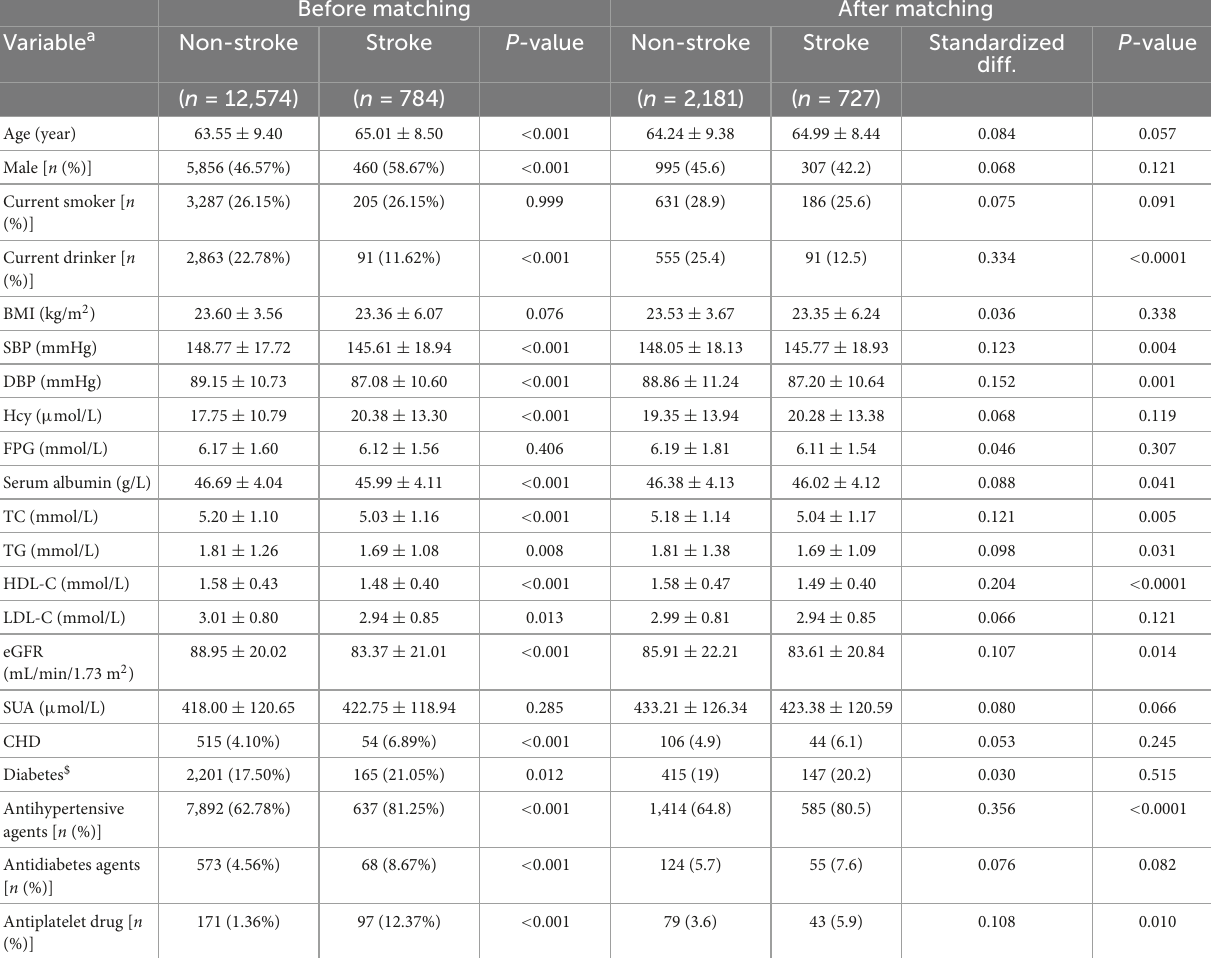
TABLE 3 Baseline characteristics of study participants with and without stroke before and after matching (after a 1: 3 match). Before matching After matching